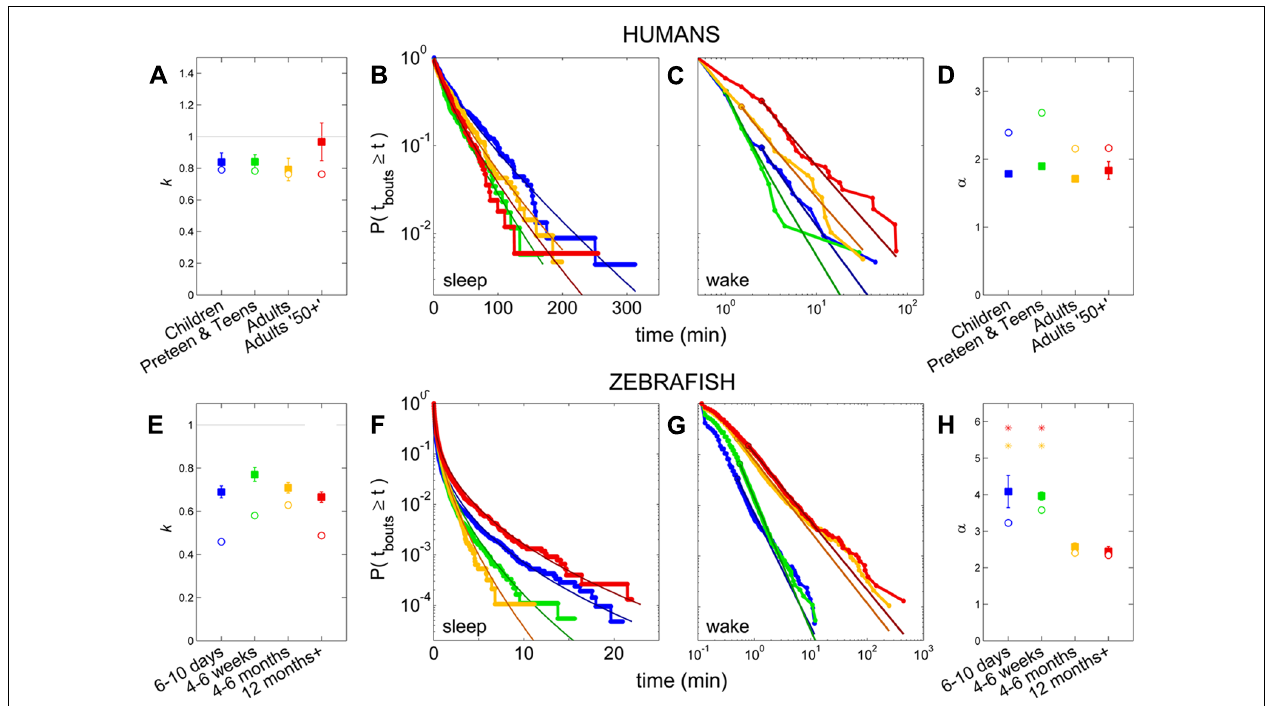
FIGURE 6 | Survivor plots of sleep and wake bouts in humans and zebrafish. (A–D) Sleep and wake bout distributions and fits in humans, with Children (blue), Preteens and teens (green), Adults (orange), and Adults 50 + (red). (E–H) Sleep and wake bout distributions and fits in zebrafish, with 4–6 days (blue), 4–6 weeks (green), 4–6 months (orange), and 12 months + (red). (B,F) Sleep bout distribution of pooled values for each group, with overlain stretched exponential fits in darker shades, shown on a log-lin scale. A straight diagonal line on these axes would indicate an exponential distribution. (A,E) Open circles indicate the value of the shape parameter k of the stretched exponential fit to the pooled distributions, while filled squares show the mean of the k ’s from fits to each individual and error bars show the standard error of the mean. The